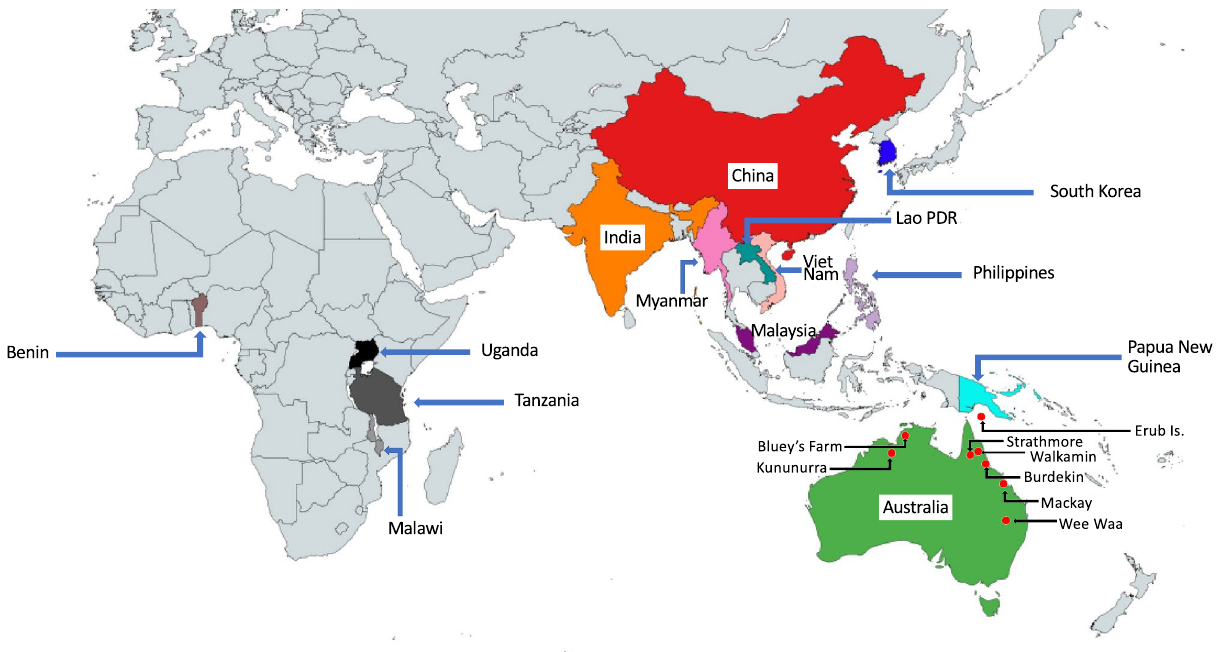
Figure 6. Countries where invasive populations of FAW surveyed for genomic analyses in this study were collected from (see main text, Table S1). Native New World populations (not shown) and invasive populations from Benin, Uganda, Tanzania, Malawi, India, and China have been reported in Tay et al. 33 . Geographic regions of the sampled countries were as defined by World Atlas and are provided in Table S1. The map was created by importing the colour-formatted map region from MapChart < https:// www. mapch art. net > into Microsoft PowerPoint for Mac v16.54 where location details were added and further manipulated and